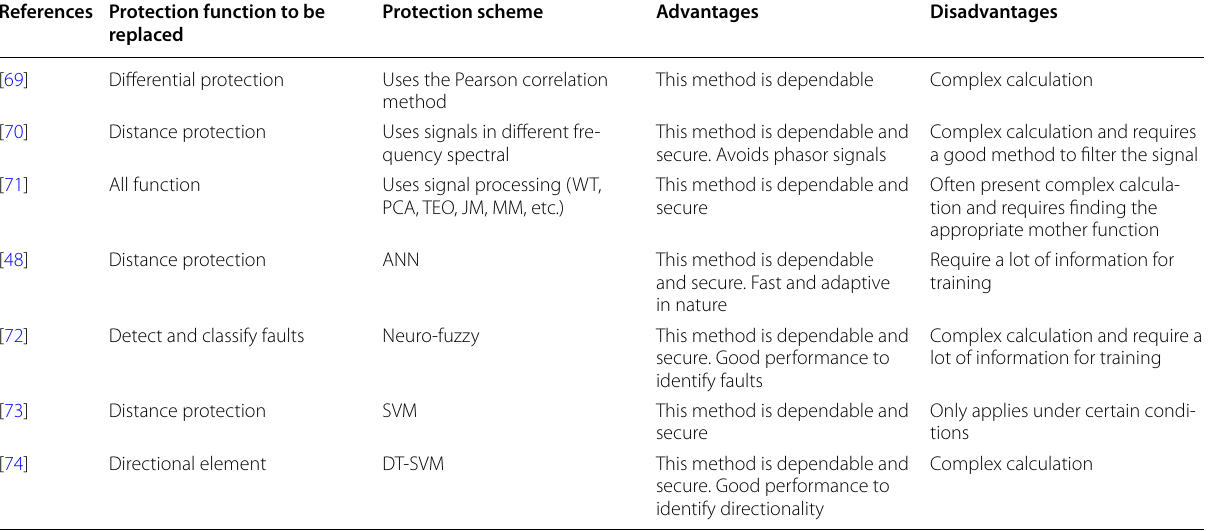
Table 10 Protection schemes based on transient signals and/or artificial intelligence References Protection function to be